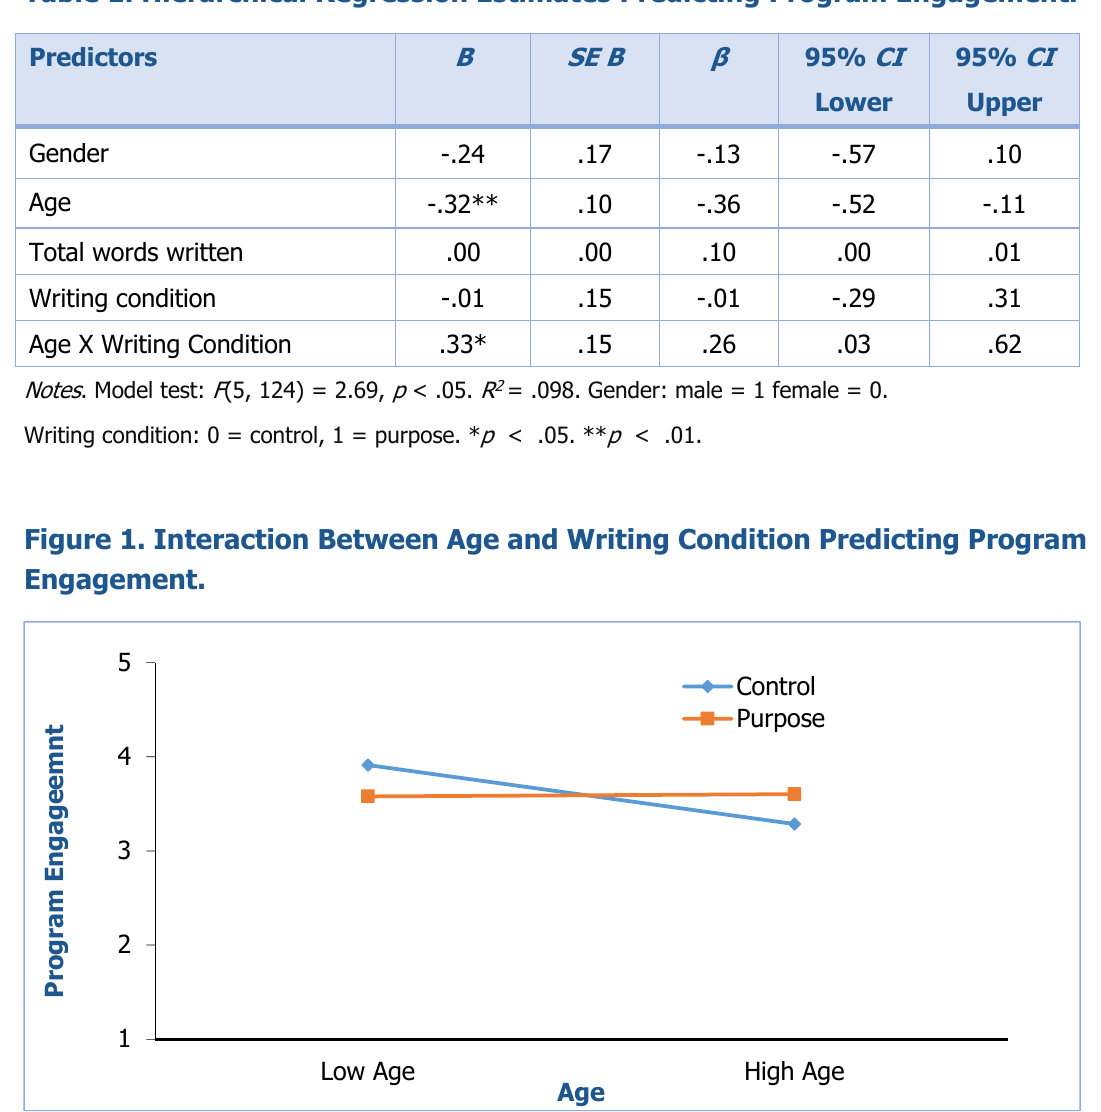
Table 1. Hierarchical Regression Estimates Predicting Program Engagement.